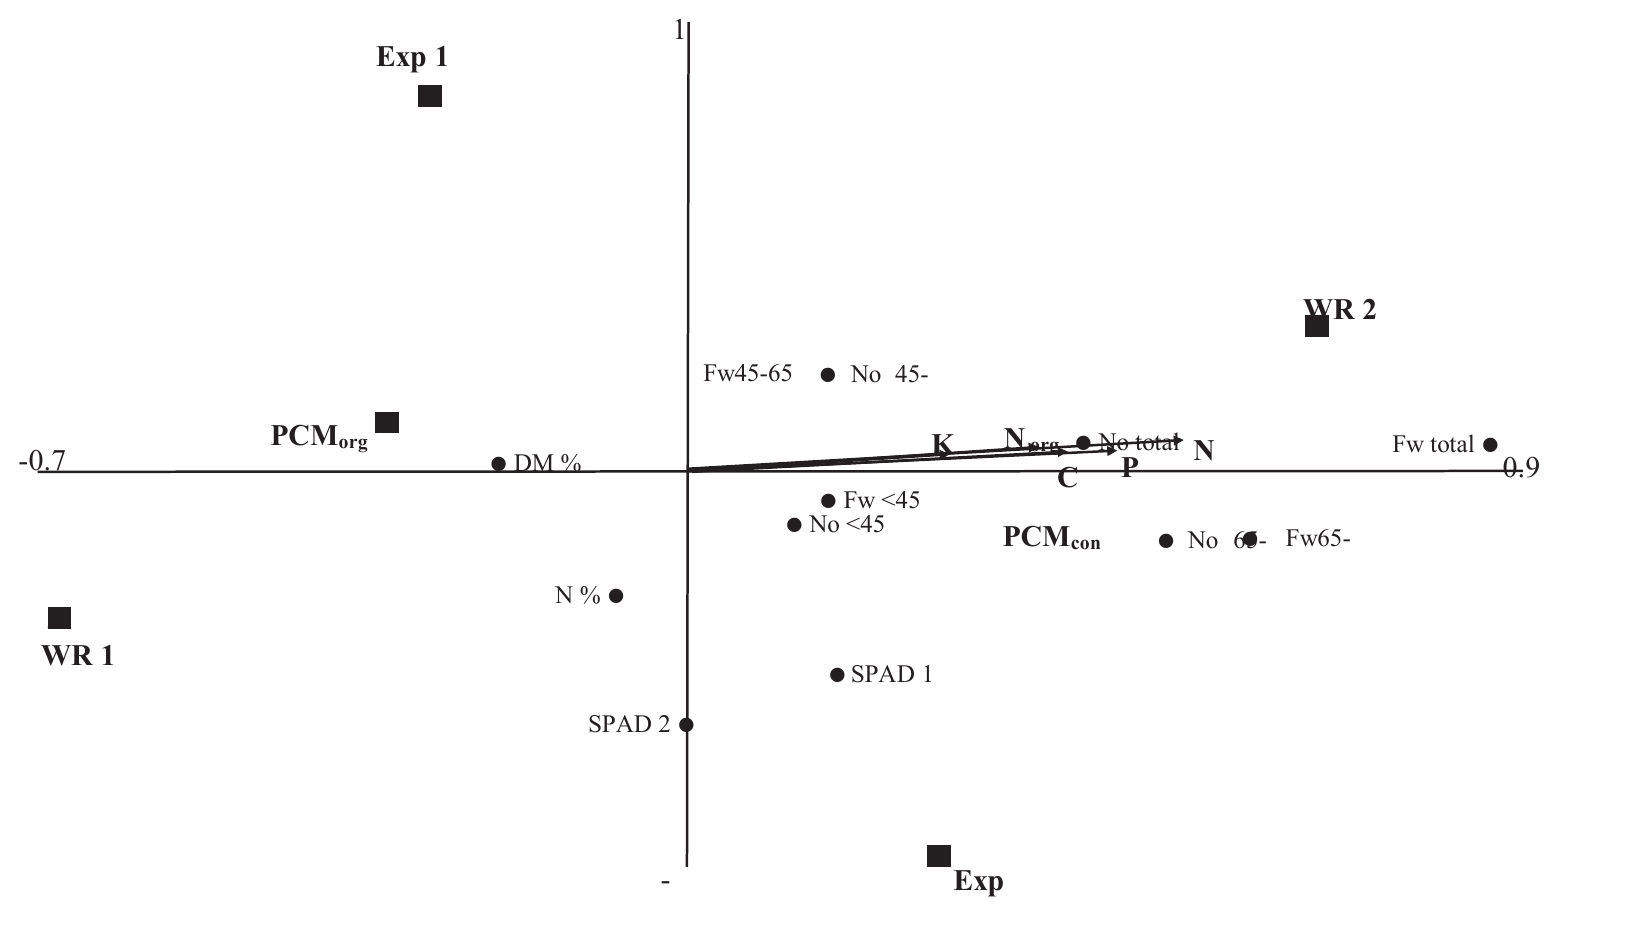
Figure 1. Bi-plot derived from redundancy analysis showing the relationship between potato tuber yield components and agronomic factors (categorical variables: organic and conventional previous soil management (PCM (WR1, WR2), experiments 1 and 2 (Exp 1, Exp 2) indicated by black squares; continuous variables: C, P, K, organic-N [N